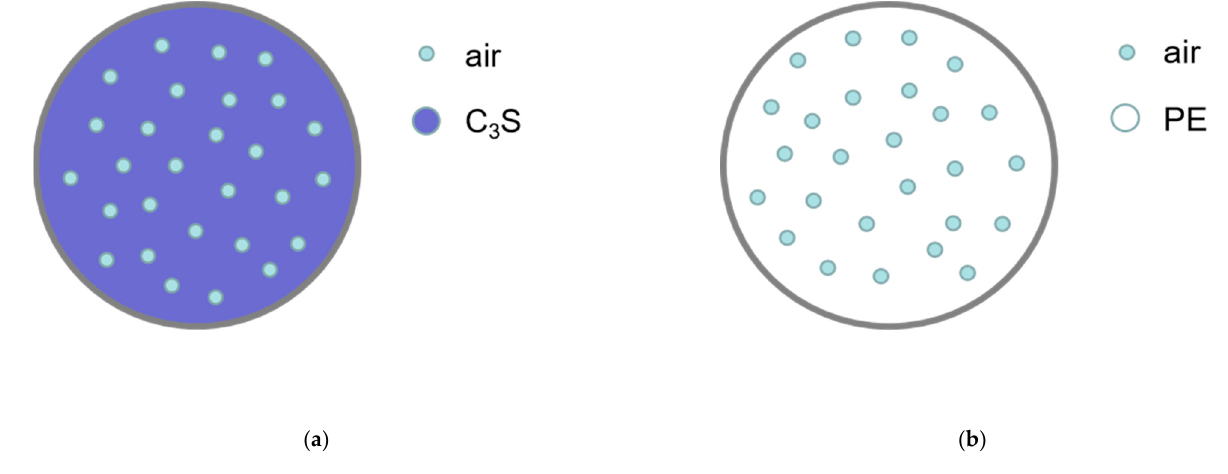
Figure 7. Schematic drawing of C 3 S and PE disc samples: ( a ) C 3 S disc; ( b ) PE disc.